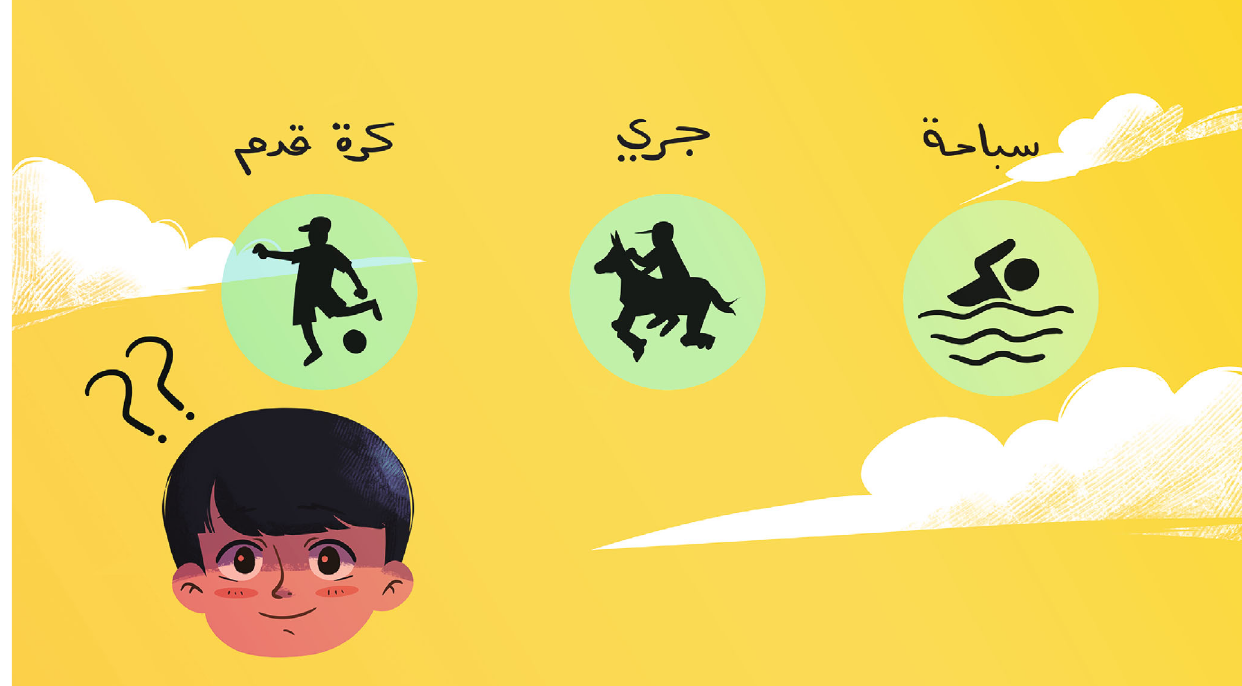
Figure 9: Physical activities screen.